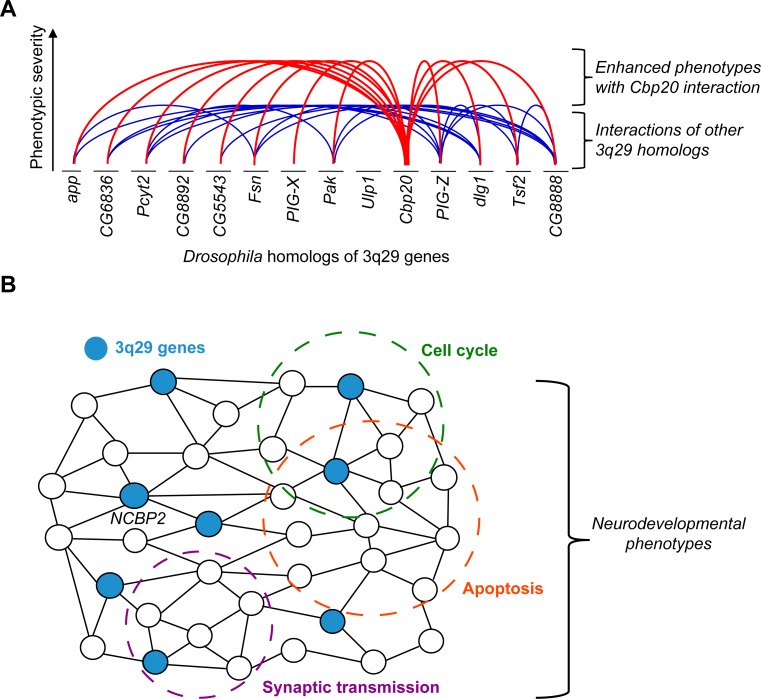
Interactions between NCBP2 and other homologs of 3q29 genes contribute to neurodevelopmental defects through conserved cellular pathways.(A) We identified 44 interactions between pairs of Drosophila homologs of 3q29 genes. With the exception of Ulp1 (SENP5), the cellular phenotypes of each homolog were significantly enhanced with simultaneous knockdown of Cbp20. While other homologs of 3q29 genes also interact with each other, our data suggest that Cbp20 is a key modulator of cellular phenotypes within the deletion region. (B) Schematic representing the network context of NCBP2 and other genes in the 3q29 region towards neurodevelopmental phenotypes. We propose that the effects of NCBP2 disruption propagate through a network of functionally-related genes, including other 3q29 genes (highlighted in blue), leading to a cascade of disruptions in key biological mechanisms, including apoptosis and cell cycle pathways. These pathways jointly contribute towards the observed neurodevelopmental phenotypes.